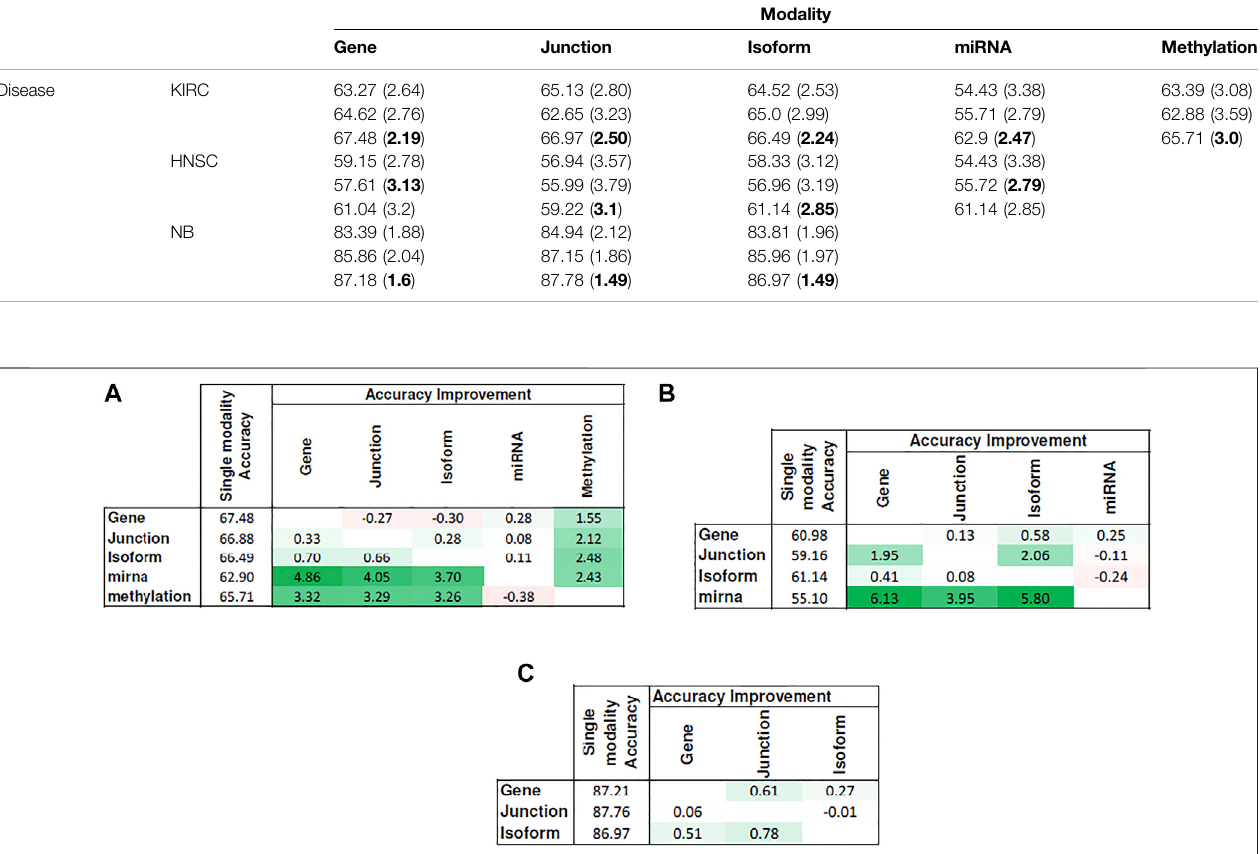
TABLE 2 | Mean (SD) of accuracies for 100 randomly initialized runs. The DBN has the smallest variance for the majority of datasets/modalities.